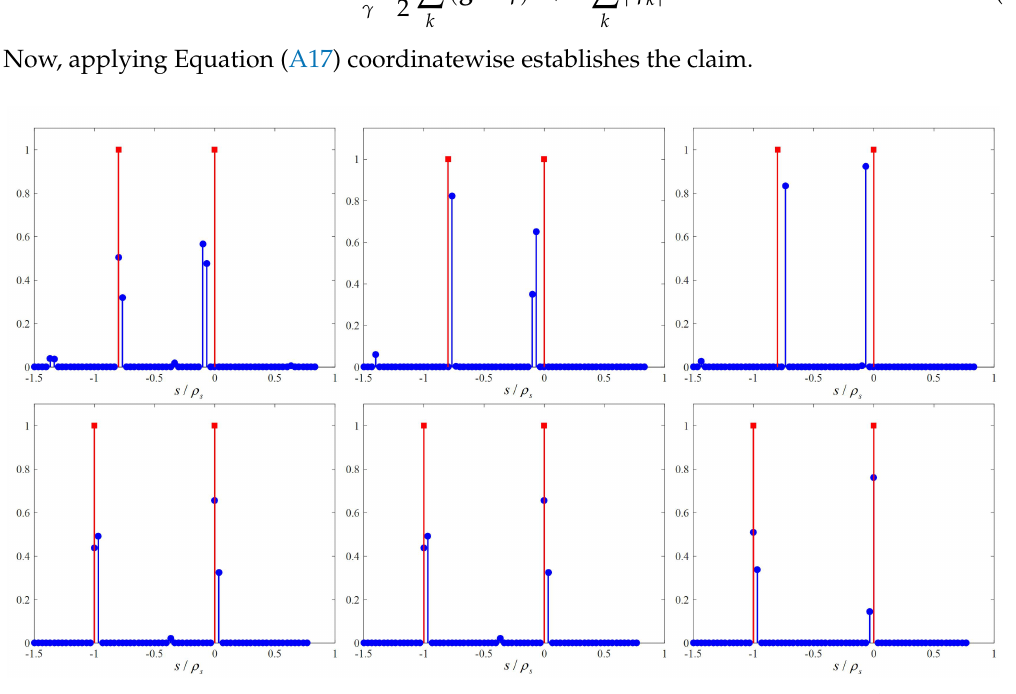
λ K , λ K ,2 λ K , 2